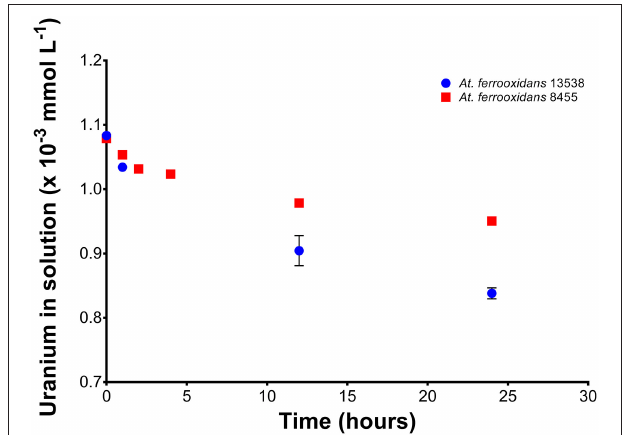
FIGURE 4 | Kinetics of the biosorption removal of U(VI) by At. ferrooxidans strains 8455 and 13538. The data fits a pseudo-first order equation. Bacteria strains are more efficient removing U(VI) from simulated mine water solution compared to growth media or uranyl salt solution.